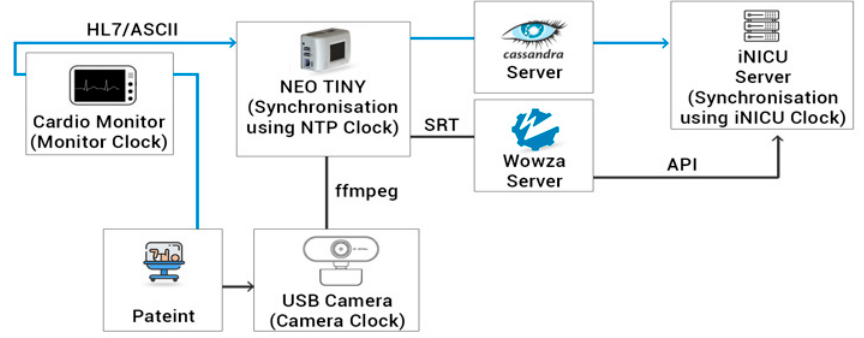
Figure A5. Synchronization of physiological data and video data with the server clock. The time difference between video and physiological signals is adjusted at regular time intervals. In the current study, regular time intervals of 10, 30, 60, and 120 min were tried for offset calculations; 60-min video recordings were most optimum. The server rec- ords the incoming video stream by splitting the recording every hour to manage the off- sets [50]. The current time of the NTS client is injected as meta-data into both video and physiological data streams. Moreover, a scheduled Cron job runs every 30 min to synchro- nize the NTS client’s clock with the NTP server (configurable using XML). As both video and physiological signals are captured, the offset (difference) between the two clocks increases based on hardware and processing capabilities. This offset in mil- liseconds is depicted in Table A3. After 60 min, the time offset between the clocks was around 549 milliseconds. To ensure the synchronization of video and monitor data, the video clock was reset every 60 min by the offset time. Table A3. Meta-data injection to ensure the video is treated as per clock of physiological signal, as a sample. Time Elapsed